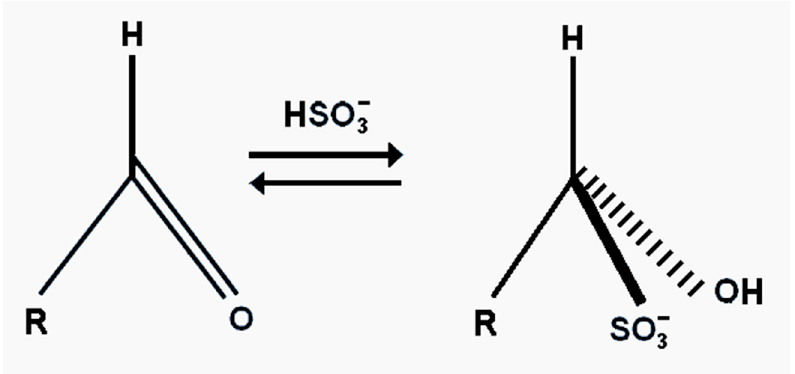
Figure 21. Binding of bisulphite to carbonyls.